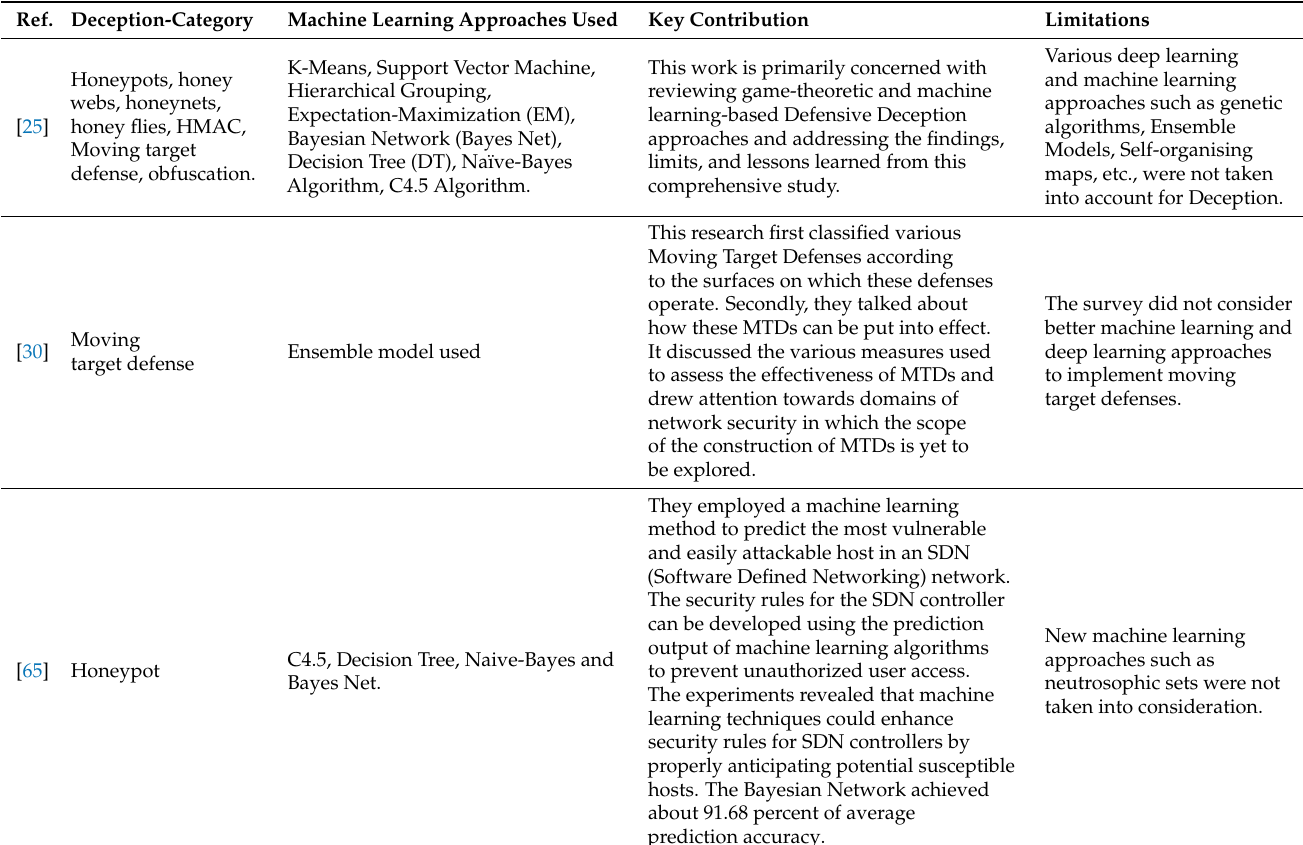
Table 2. A summary of works on machine learning techniques in defensive